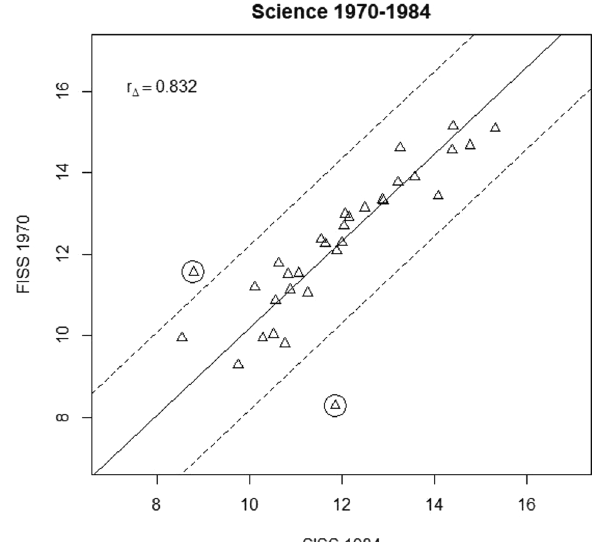
Fig. 7 Delta plot of the bridge between FISS and